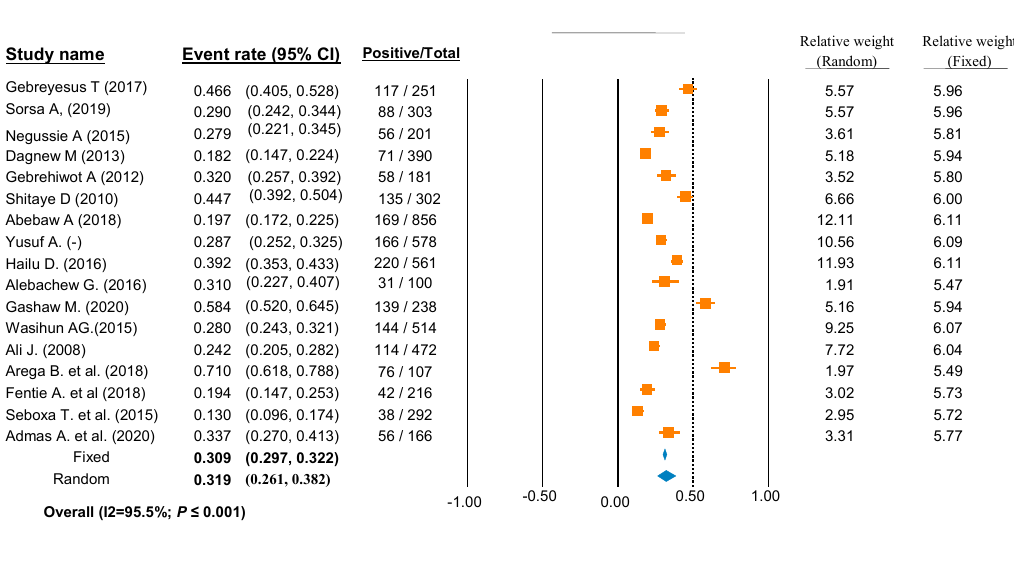
Figure 2: Overall blood culture positive rate of septicemia cases in different region of Ethiopia.